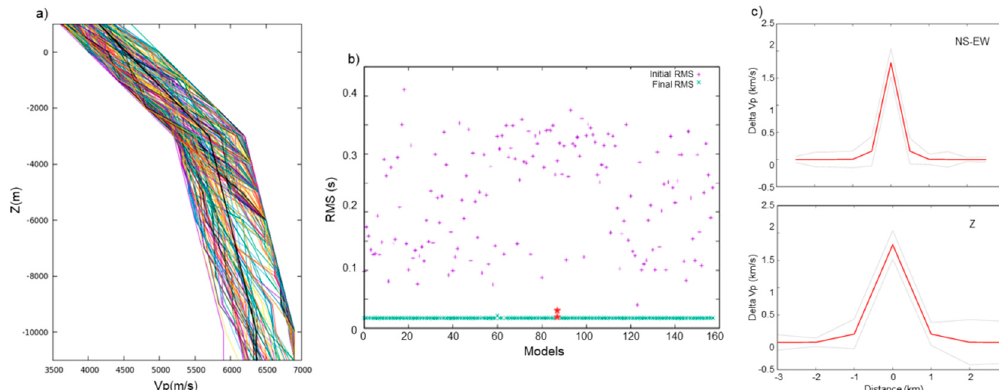
Figure 5. Evaluation of initial velocity model influence. ( a ) The 200 random velocity models obtained in the range of ± 1km with respect to the reference one (solid black line). ( b ) Initial (purple) and final (turquoise) distribution of time residual root mean squares (RMS) obtained by the inversions with the 200 initial velocity models in the case of rate = 500 m 3 /day and D = 0.1 m 2 /s, after one month of continuous injection. ( c ) True velocity anomaly (red solid lines) contoured by the standard deviation (gray solid lines) of retrieved models in the NS-EW direction (upper panel) and in the Z direction (lower panel). The red stars indicate the initial and final rms obtained with the reference initial velocity model.